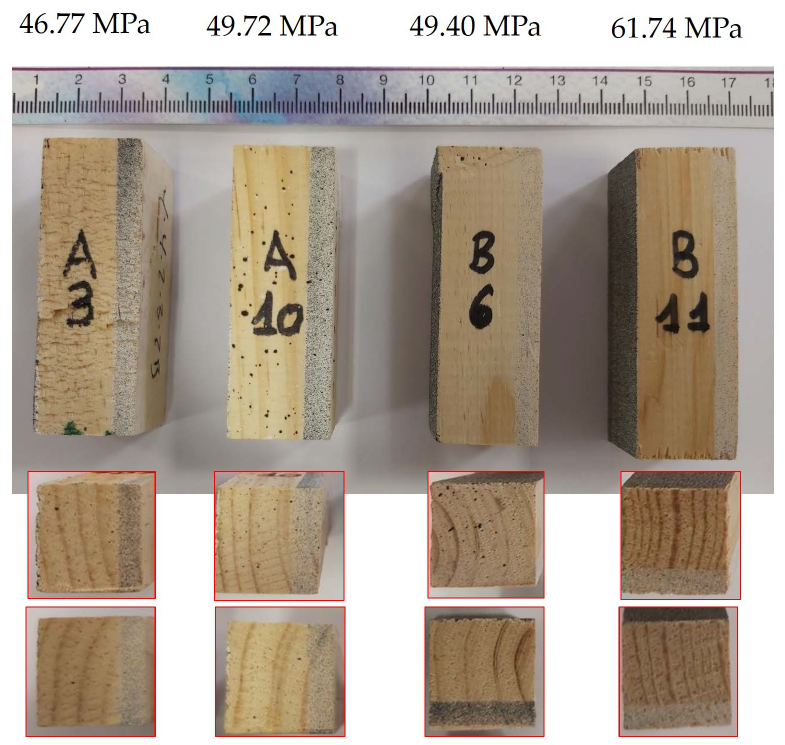
14 Figure 14. Appearance of the specimens selected for